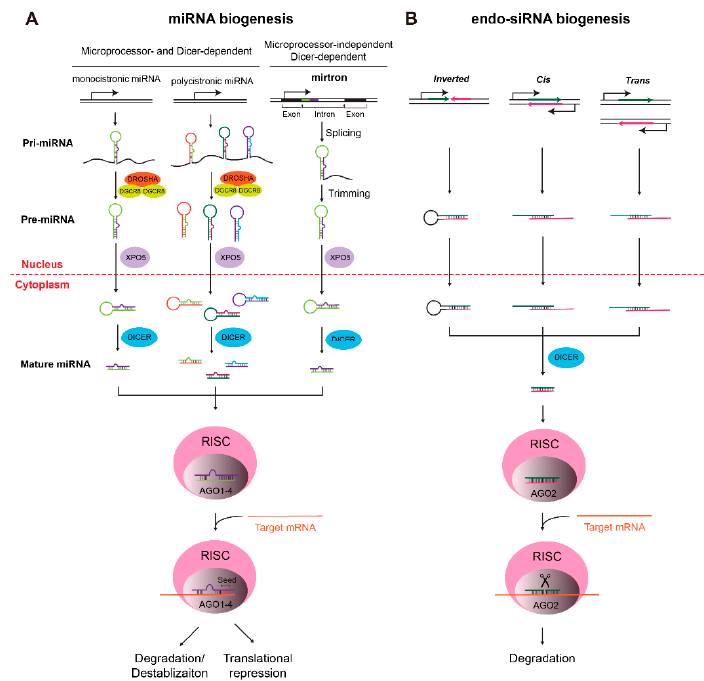
Figure 1: Dicer-dependent biogenesis of miRNAs ( A ) and endo-siRNAs ( B ). ( A ) Biogenesis of miRNAs can be microprocessor- and DICER-dependent (monocistronic and polycistronic miRNAs), or microprocessor-independent and DICER-dependent (mirtrons), with very few exceptions. For the former, monocistronic and polycistronic miRNAs are transcribed by RNA polymerase II as primary miRNAs (pri-miRNAs), which are processed by the microprocessor complex (DROSHA and DGCR8) and exported to the cytoplasm as precursor miRNAs (pre-miRNAs) for the further processing by DICER. Mirtrons, in contrast, are located in the intron and are generated by splicing and trimming that do not need the microprocessor complex to form pre-miRNAs. In both cases, pre-miRNAs need DICER for forming short mature miRNA duplexes. One strand of the duplex is then loaded onto the RNA-interference complex (RISC), where the miRNA recognizes its target mRNA through imperfect base pairing, especially the complementation between the short “seed” sequence of the miRNA and its mRNA targets, performing post-transcriptional silencing on target mRNAs through degradation or translational repression. ( B ) The biogenesis of endo-siRNAs starts with the formation of duplexes from one or two transcripts with complementary sequences. Duplexes are exported to the cytoplasm and processed by DICER as well. Different from miRNAs, endo-siRNAs duplex with their target mRNAs with a higher degree of complementation, inducing the splicer activity of Ago2 for the cleavage of mRNAs, leading to its degradation. Please note that miRNA RISC can be formed with Ago1–4, while the RISC for endo-siRNAs contains Ago2.